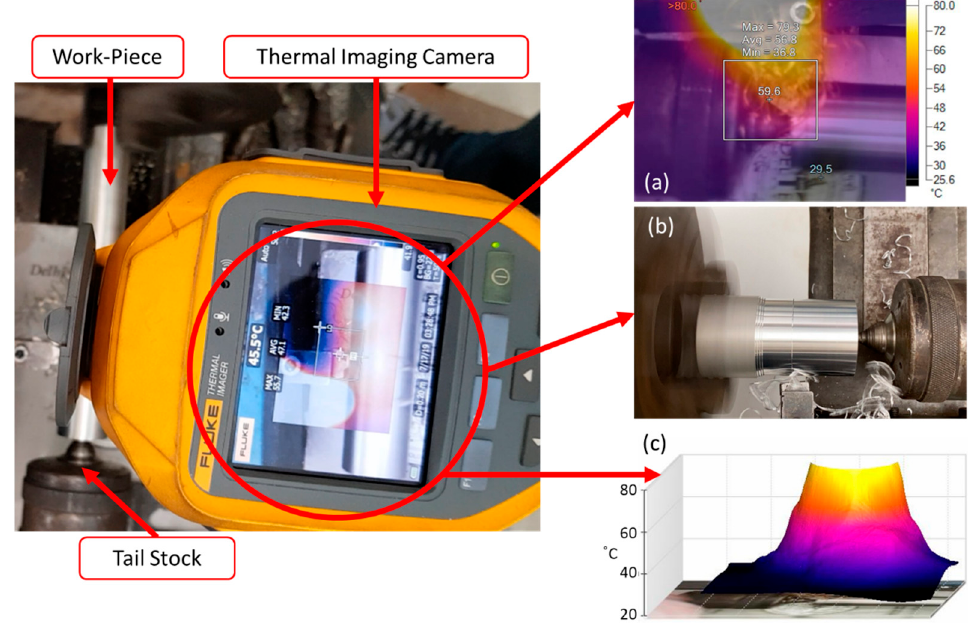
Figure 3. Thermal imaging camera under the process of taking the thermal images; ( a ) thermal image of the cutting tool at its contact point, ( b ) image of DLC-coated cutting tool under the turning process and ( c ) graph of temperature variation for the cutting tool at its contact point and its surroundings.